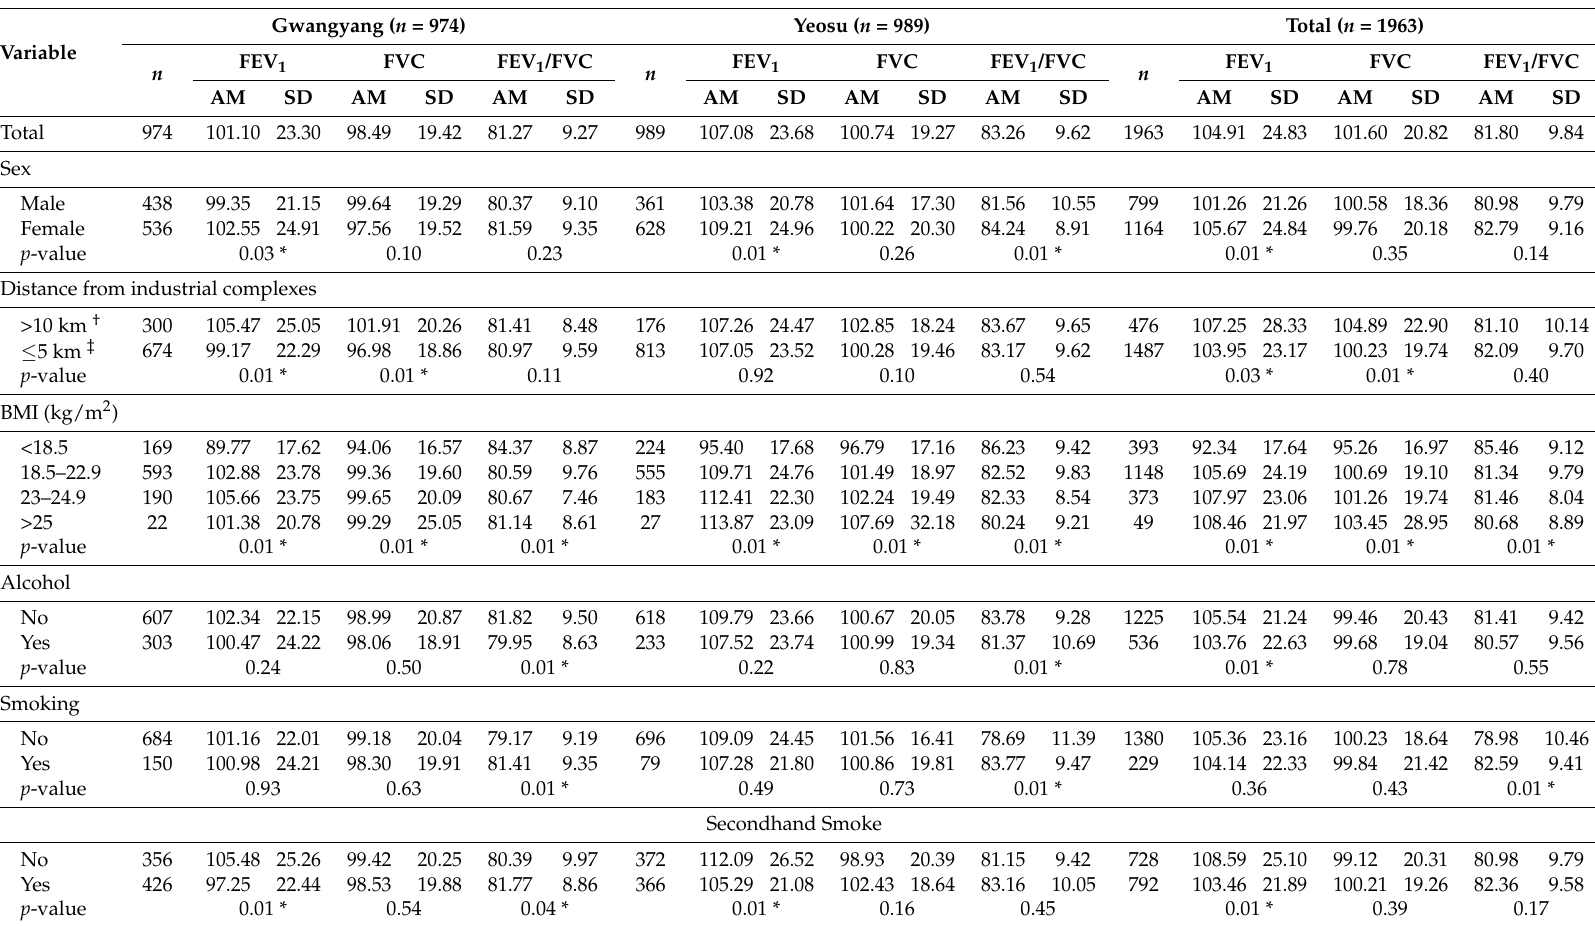
Table 3. Summary statistics of pulmonary function levels of all residents with general characteristics, personal lifestyle, and air